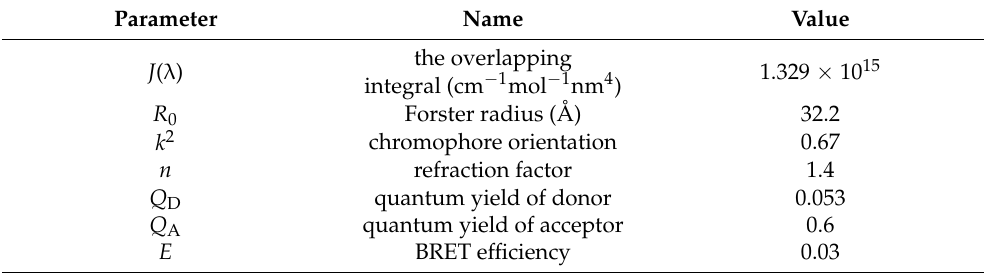
Table 2. BRET parameters for the complex of barnase and barstar fused with RLuc and EGFP, respectively.